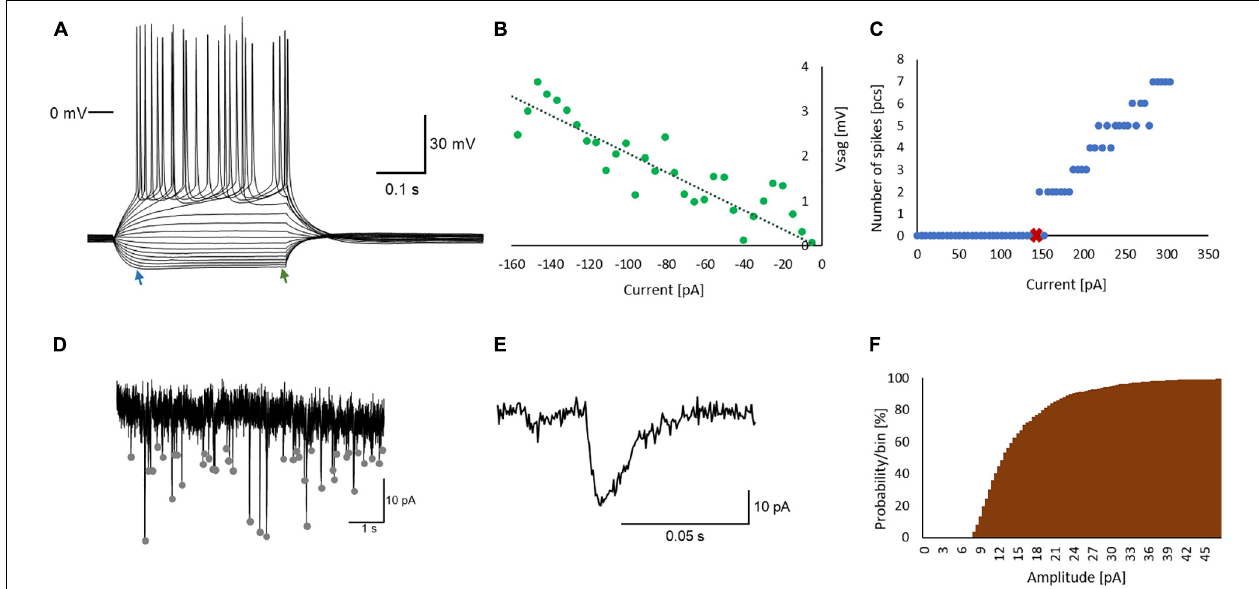
FIGURE 1 | Experimental protocols used in whole-cell patch clamp measurements in CA1 pyramidal neurons. (A) Representative voltage responses to gradually increasing current steps. Voltage sag (Vsag) may appear at negative current steps and is described as the difference between the most negative point (blue arrow) and the end (green arrow) of the voltage response to the given step (B) Vsag plotted as a function of the injected current. With linear regression a line can be drawn (dotted line) through the data points. The slope of the line is used here as the Vsag index. (C) I-V curve; the number of spikes is plotted as a function of the injected current. The current evoking the first spike is the rheobase (red x). (D) Representative spontaneous excitatory postsynaptic currents, EPSCs (the autodetected events are marked with gray dots), (E) an EPSC and (F) a cumulative histogram of EPSC amplitudes.